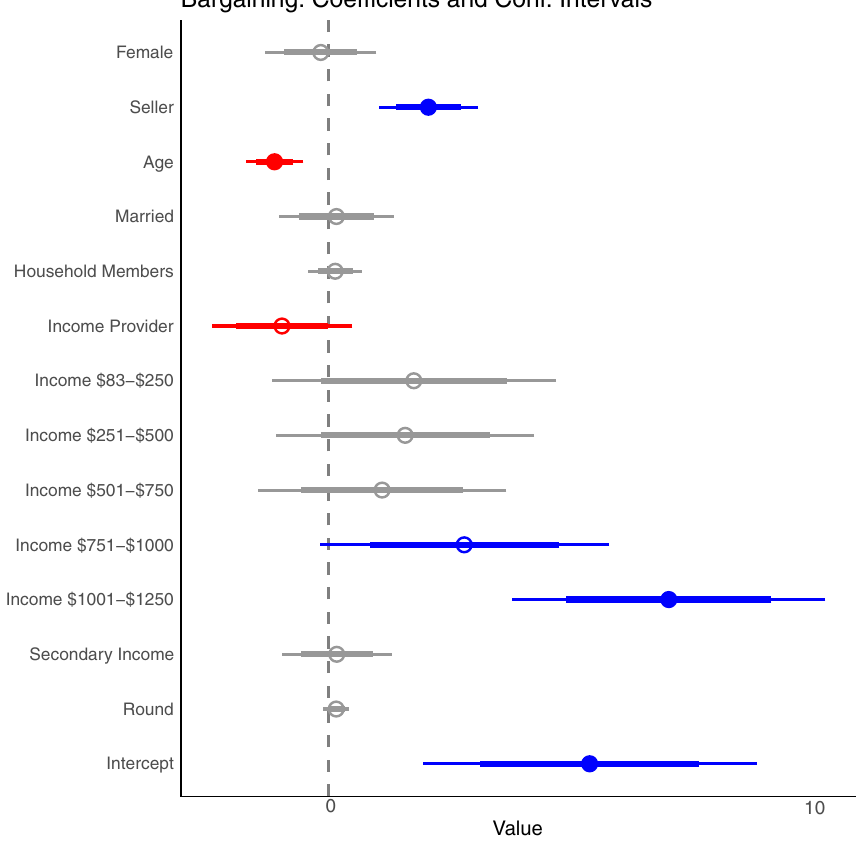
Figure 6. Coefficient plot of how the earnings from bargaining are related to gender, their role (buyer/seller), age, marital status, number of household members, whether a subject was the income provider, the levels of monthly income (in USD), whether the subject had a secondary non-fishing related income, and the round number. Thick lines represent 80% confidence interval, while thin lines are 95% confidence